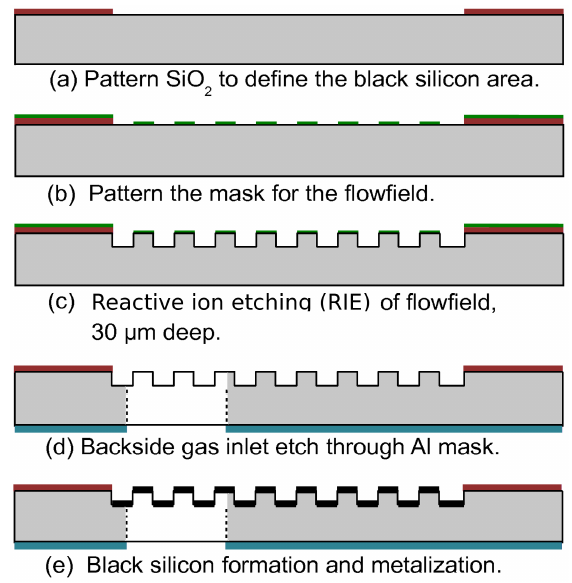
Figure 5. Fabrication steps for a single silicon bipolar